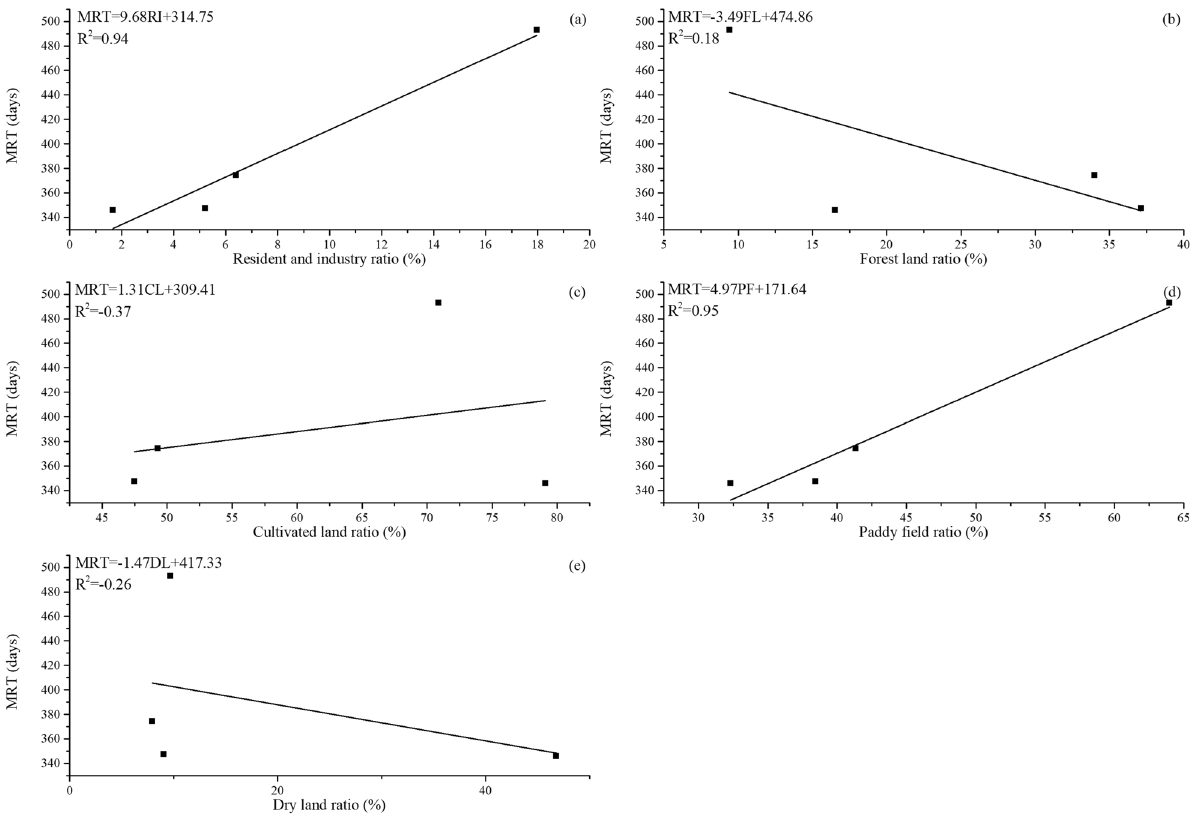
Figure 6. Relationships between resident and industrial area ratio ( a ), forest land ratio ( b ), cultivated land ratio ( c ), paddy field ratio ( d ), dry land ratio ( e ) and